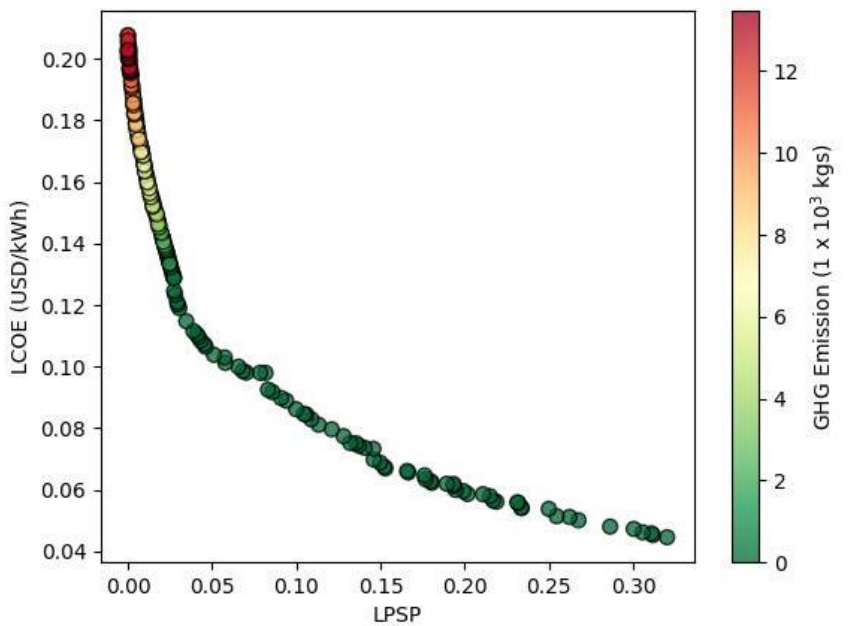
Figure 14. Two-dimensional scatter plot of frontier solution set of